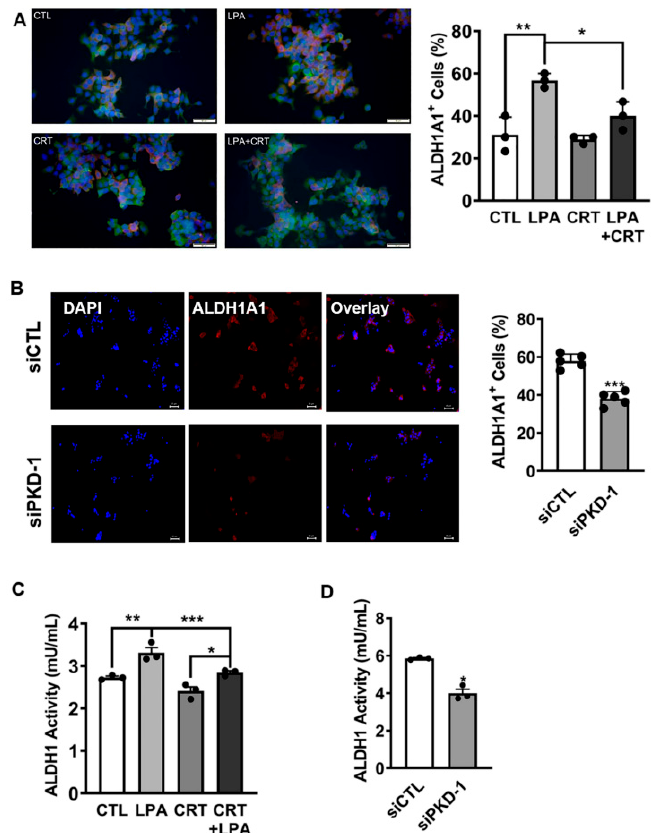
Figure 5. Association of PKD1 signaling with ALDH1. ( A ) BON cells were cultured in DMEM/F12 medium with 5% FBS. After starvation in serum-free DMEM/F12 medium for 6 h, the cells were treated with 10 µM of LPA, and/or 5 µM of CRT in serum free DMEM/F12 medium for an additional 24 h under 5% CO 2 at 37 °C. The cells were incubated with ALDH1A1 and PKD1 antibodies, followed by appropriate secondary antibodies. The percentages of cells with high levels of ALDH1A1 expression (red) were calculated by randomly counting up to 30 individual cells, and triple counting was performed. GraphPad Prism 9 was used for statistical analysis. ( B ) BON cells were transfected with scramble control or PKD1 siRNA for 24 h, and the cells were processed for staining with an ALDH1A1 antibody, followed by an appropriate secondary antibody. The ratio of cells with high levels of ALDH1A1 expression were calculated under a fluorescence microscope by counting up to 100 cells randomly in each field. Five repetitions were performed. Statistic difference was evaluated by GraphPad Prism 9. ( C ) BON cells were treated with 10 µM LPA, 2 µM CRT0066101, or their combination for 24 h. ALDH1 activity was measured by ELISA in a plate reader. ( D ) BON cells were transfected with scramble control or PKD1 siRNA to knock down endogenous expression. ALDH1 activities were measured by ELISA in a plate reader. Triplicate experiments were performed. The results were shown as the mean ± SEM. * p < 0.05, ** p < 0.01, and *** p <